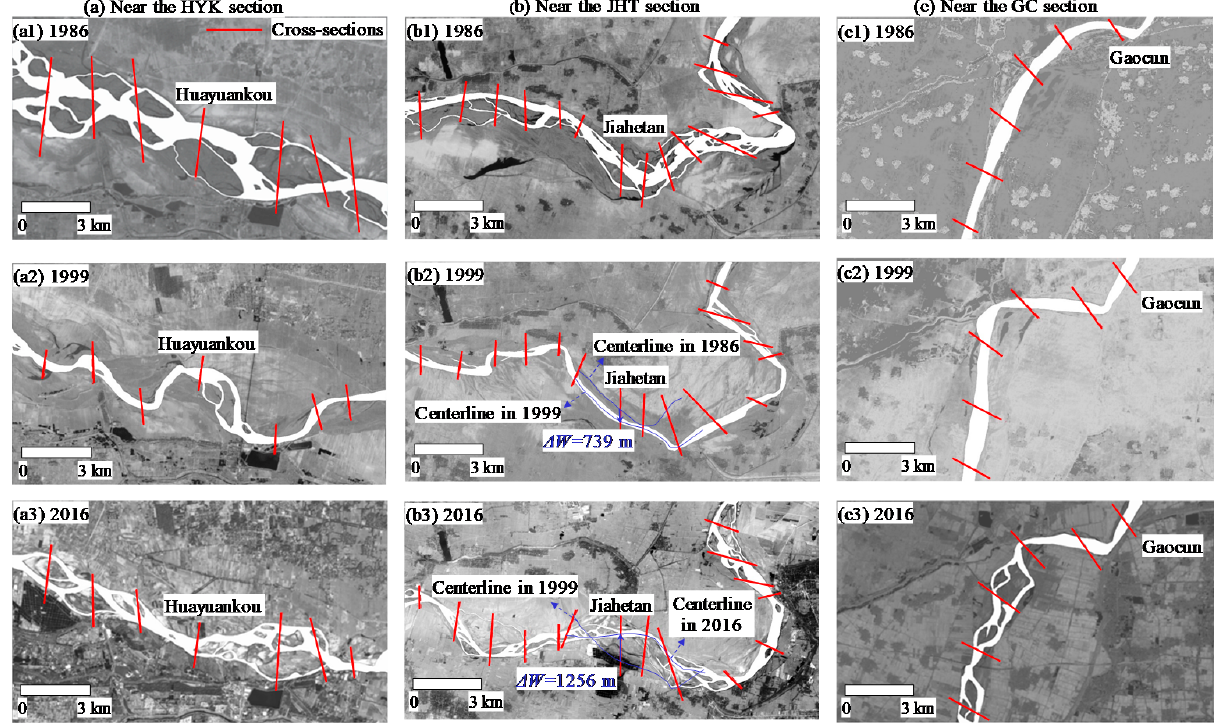
Figure 5. Remote sensing images in different years near the sections of: ( a ) HYK; ( b ) JHT; and ( c ) GC.